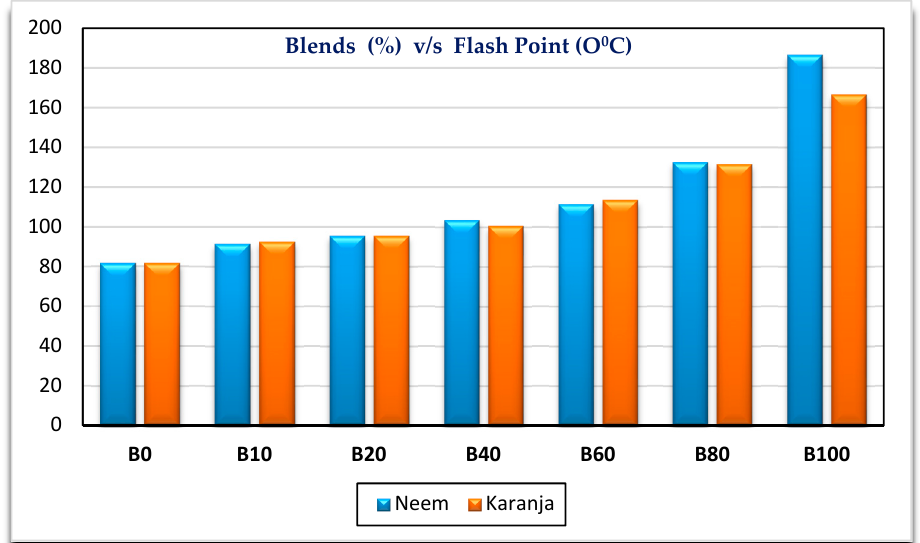
Figure 5. Variation of flash point with biodiesel-diesel blends. Table 5. Fuel properties of Karanja biodiesel-diesel blends by DT method.